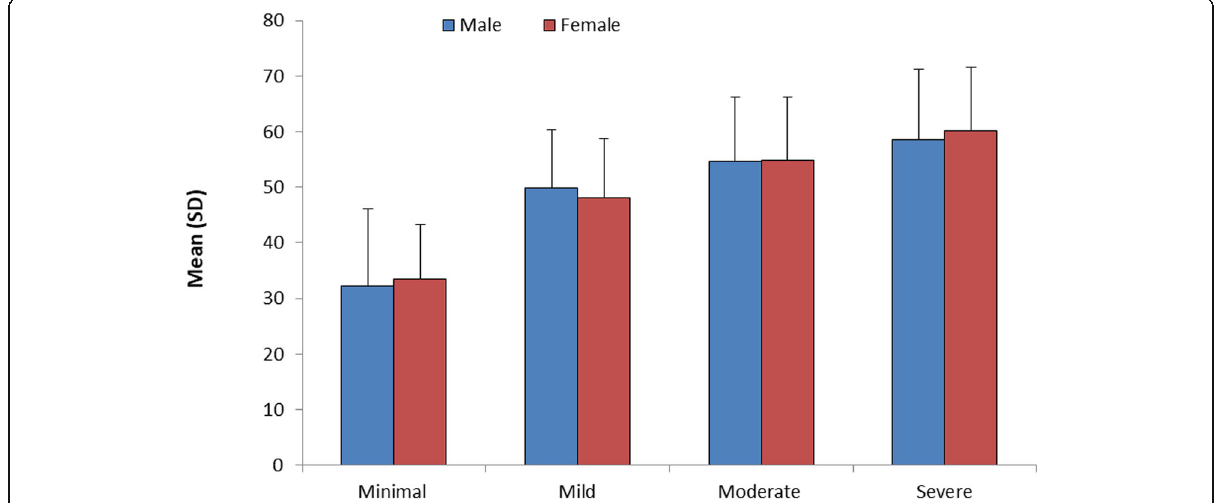
Fig. 4 Mean age of the patients based on grades of affection based on